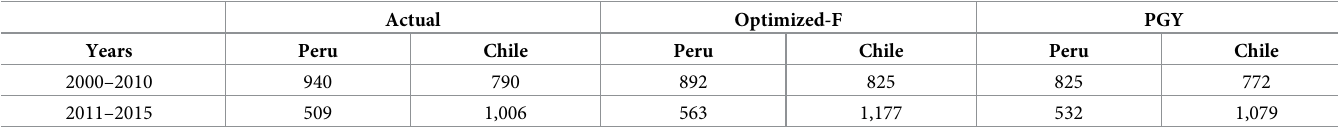
Table 4. Peru and Chile’s average actual and modeled landings (10 3 t) of the shared Southern Peru/Northern Chile stock over two time